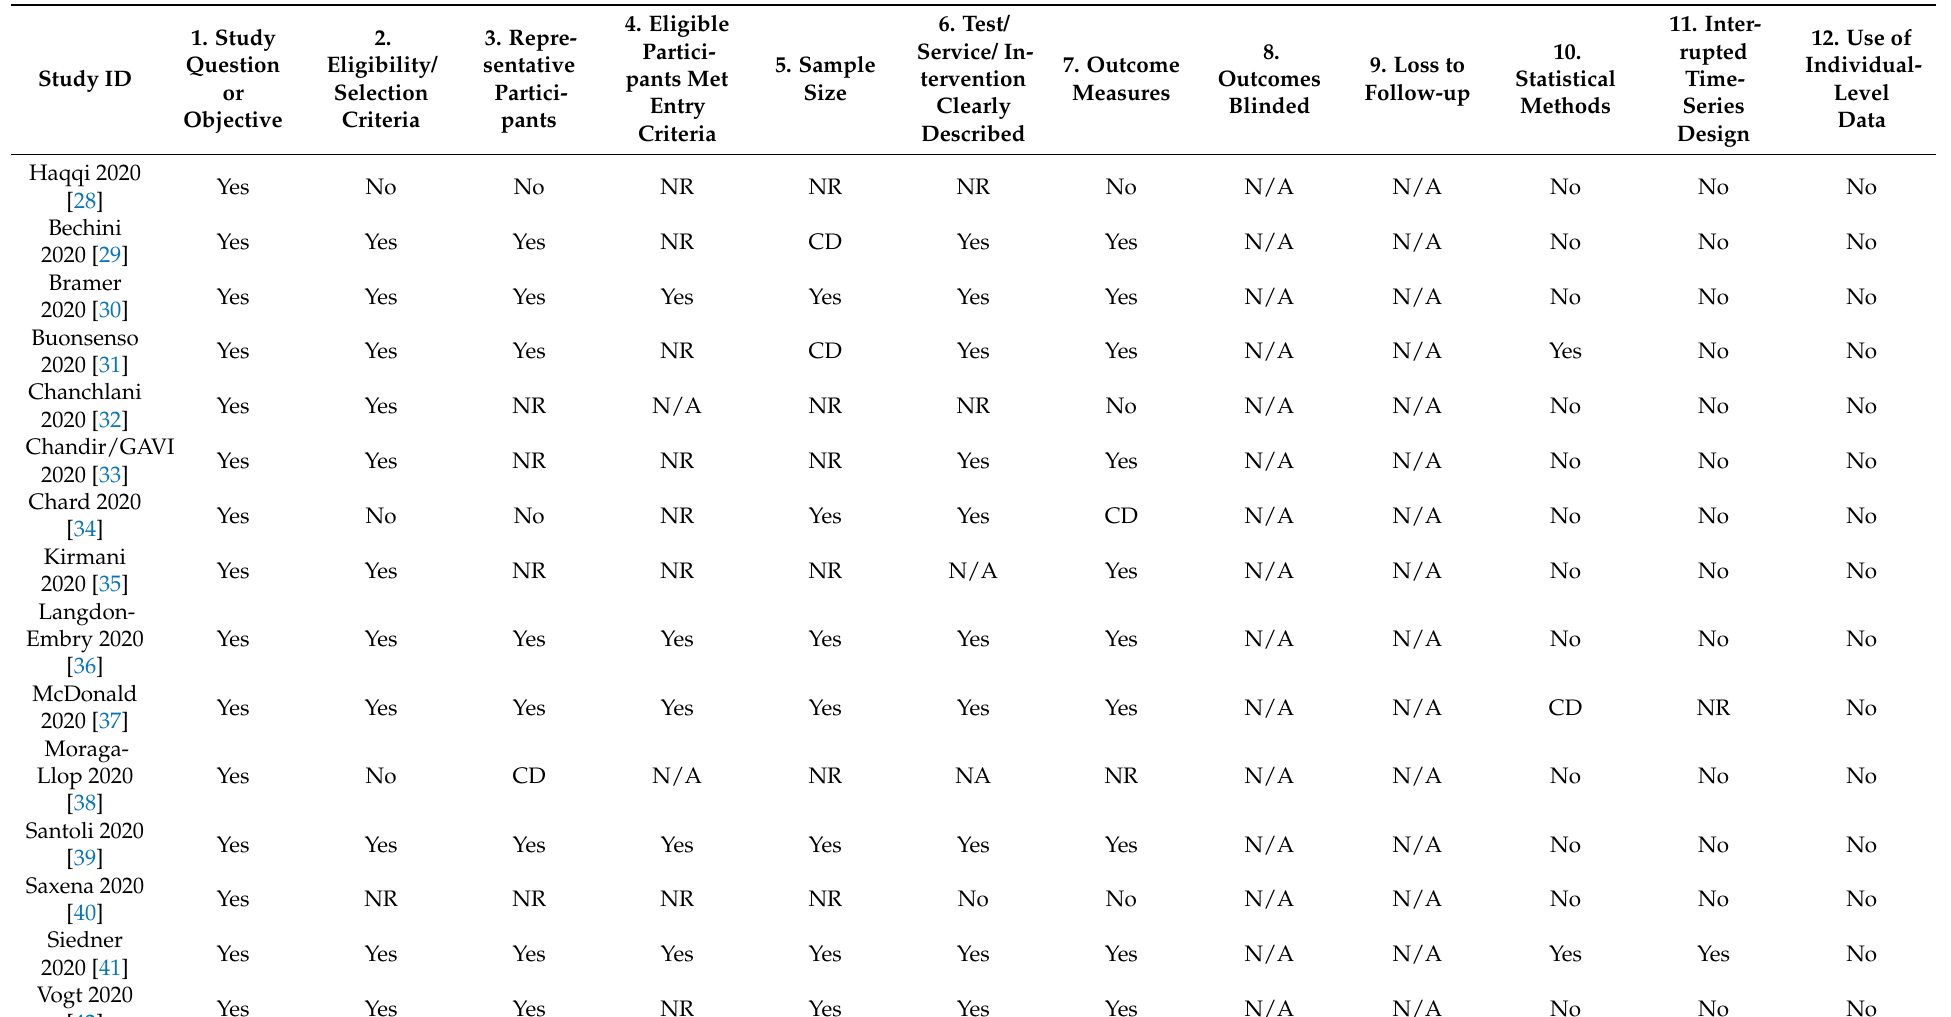
Table 3. Quality of included